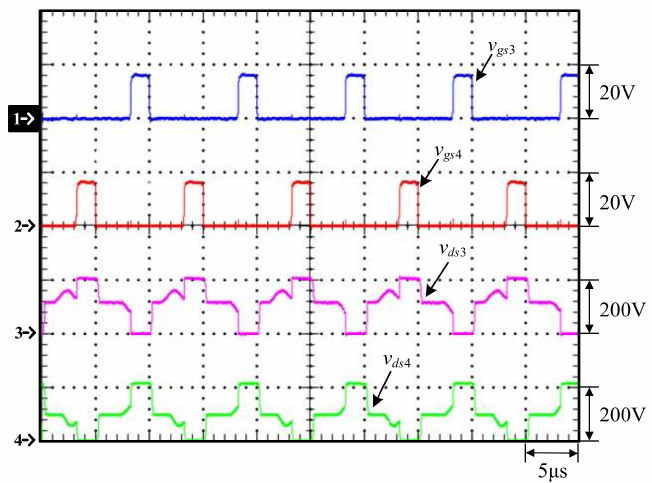
Figure 24. Measured waveforms relevant to 25% of the rated load: (1) v gs 3 ; (2) v gs 4 ; (3) v ds 3 ; (4) v ds 4